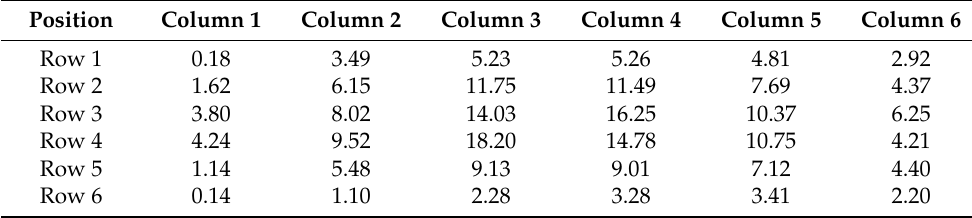
Table 6. Current of the photovoltaic panels under 4 times beam